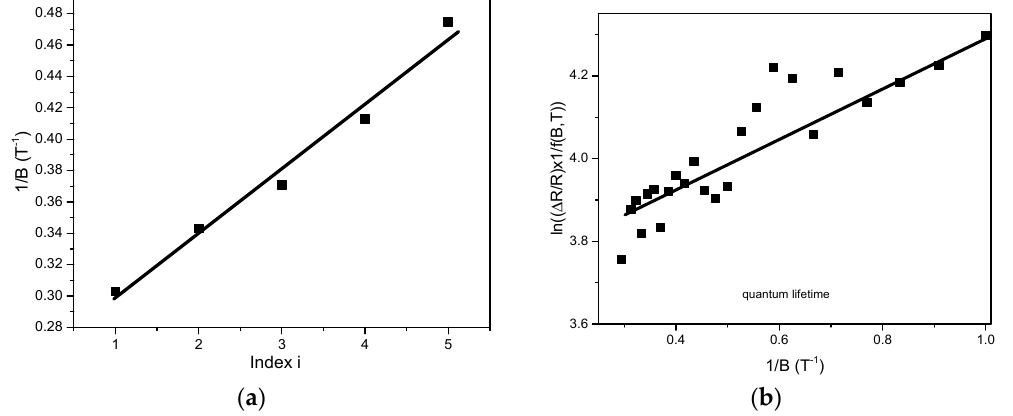
Figure 12. Extraction of the electron density in the 2DEG ( a ) and lifetime of quantum states ( b ) from measurements of SdH oscillations. The procedure is described in the text.